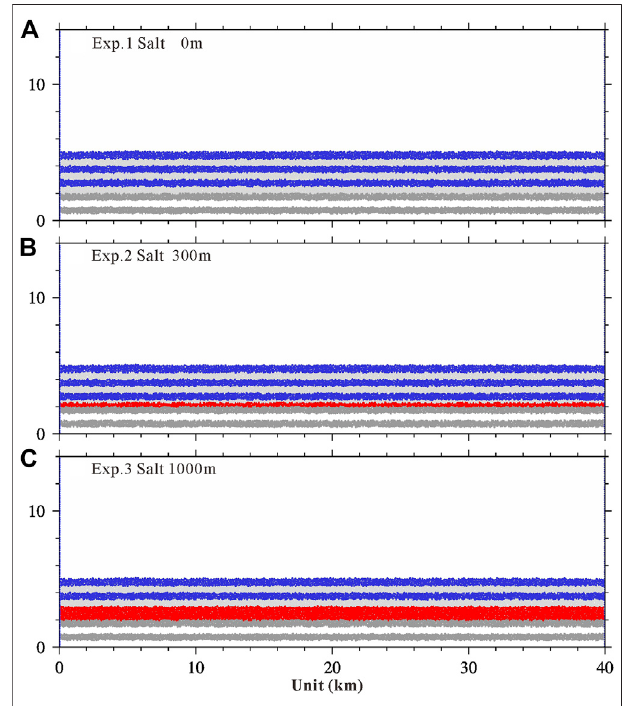
FIGURE 4 | Initial models. (A) Reference experiment without salt. (B) Experiment with thin salt (ca. 300 m tall). (C) Experiment with thick salt (ca. 1,000 mtall).Whiteandgraydenotethesubsaltstratum.Reddenotesthesalt layer. Blue and gray denote the prekinematic